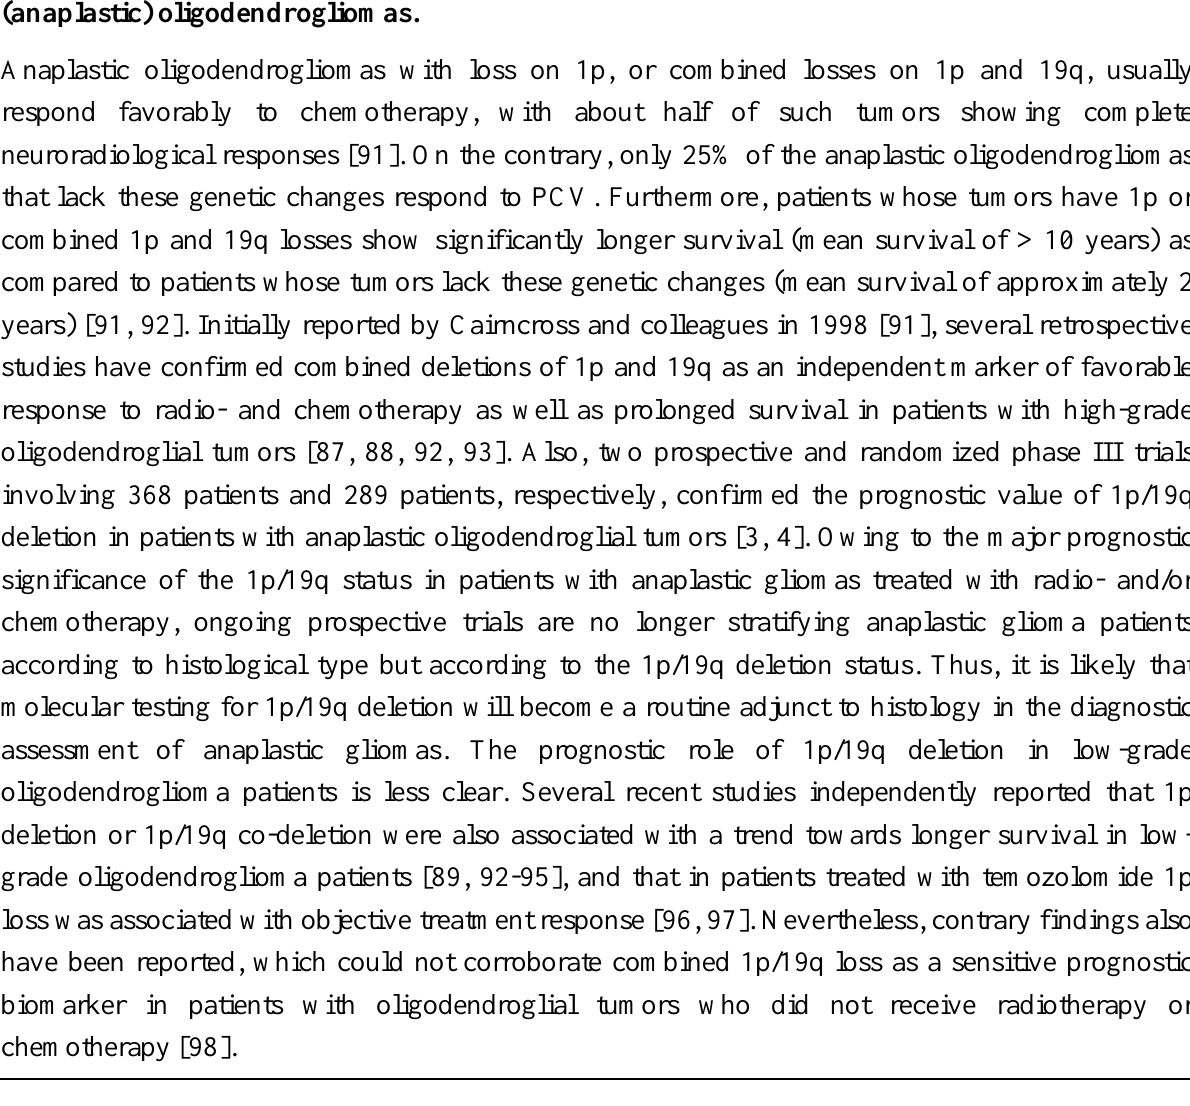
Breakout box 2: Combined deletion of chromosome arms 1p and 19q as a biomarker in (anaplastic)